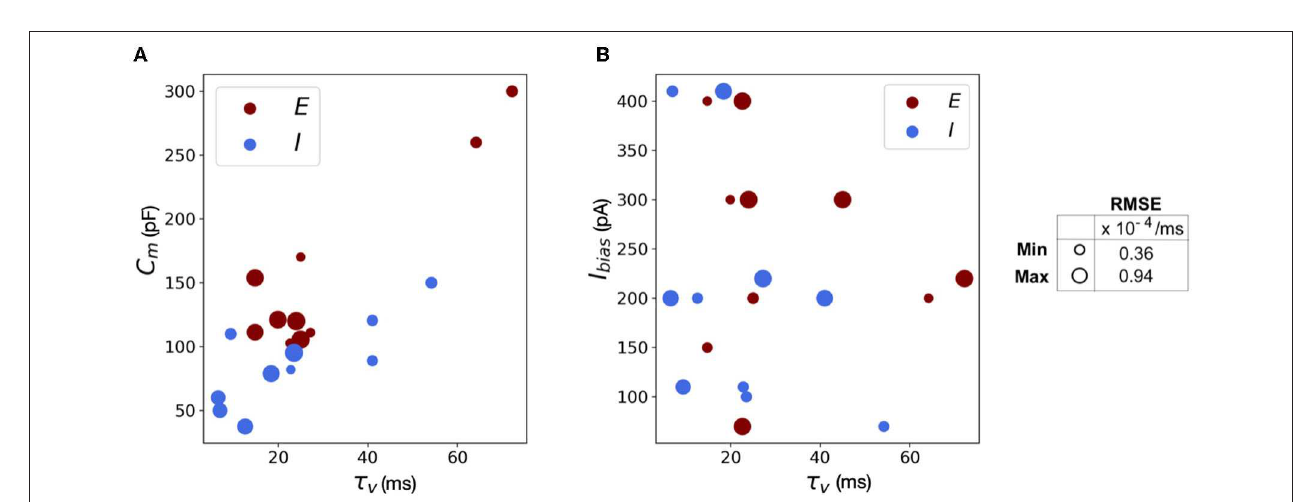
FIGURE 11 | Scatter plots showing the range of parameters for the 20 neurons classes comprising of both excitatory and inhibitory neurons grouped by RMSE of the simulations. (A) Scatter plot for membrane capacitance ( C m ) vs. membrane time constant ( τ v ). (B) Scatter plot for bias current ( I bias ) vs. membrane time constant ( τ v ). The marker size is determined by the corresponding